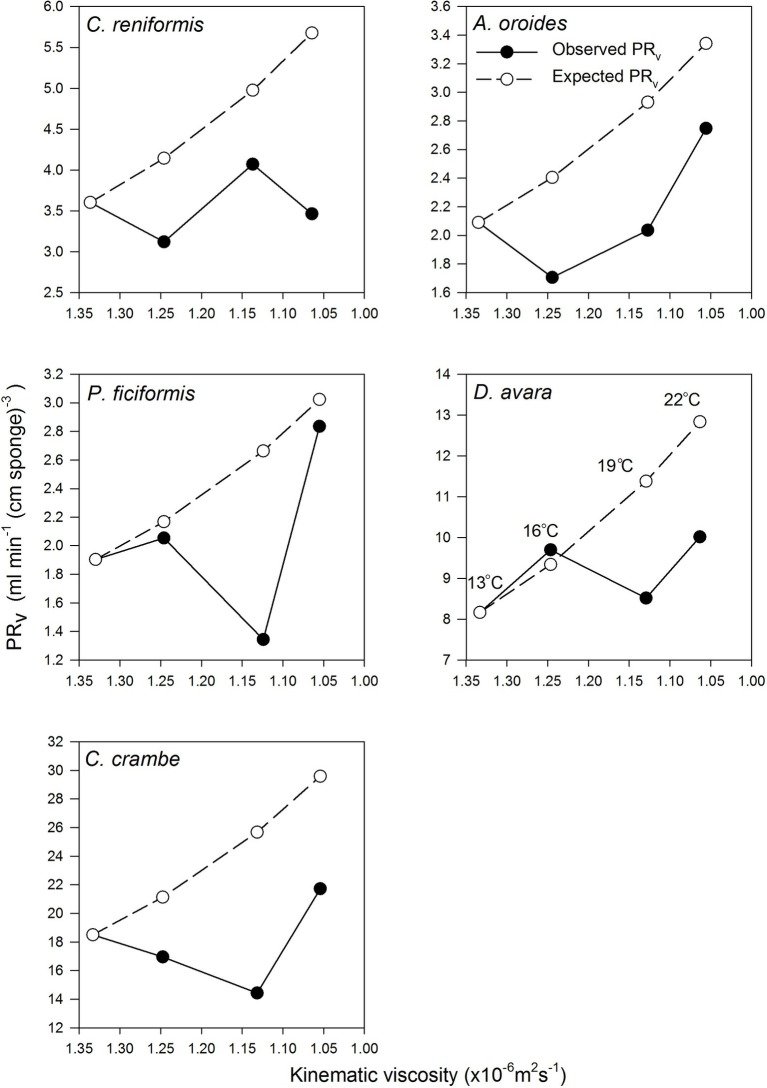
The relationships between volume-specific pumping rate [PRV, ml min−1 (cm sponge)−3] and the kinematic viscosity (v, ×10−6 m2 s−1) in the five study species examined seasonally. Observed values are presented as full circles. Expected values are presented as empty circles (see Methods text for details). Error bars were omitted for the clarity of the representation. Temperatures are indicated at different viscosities in the D. avara panel but pertain to all panels.